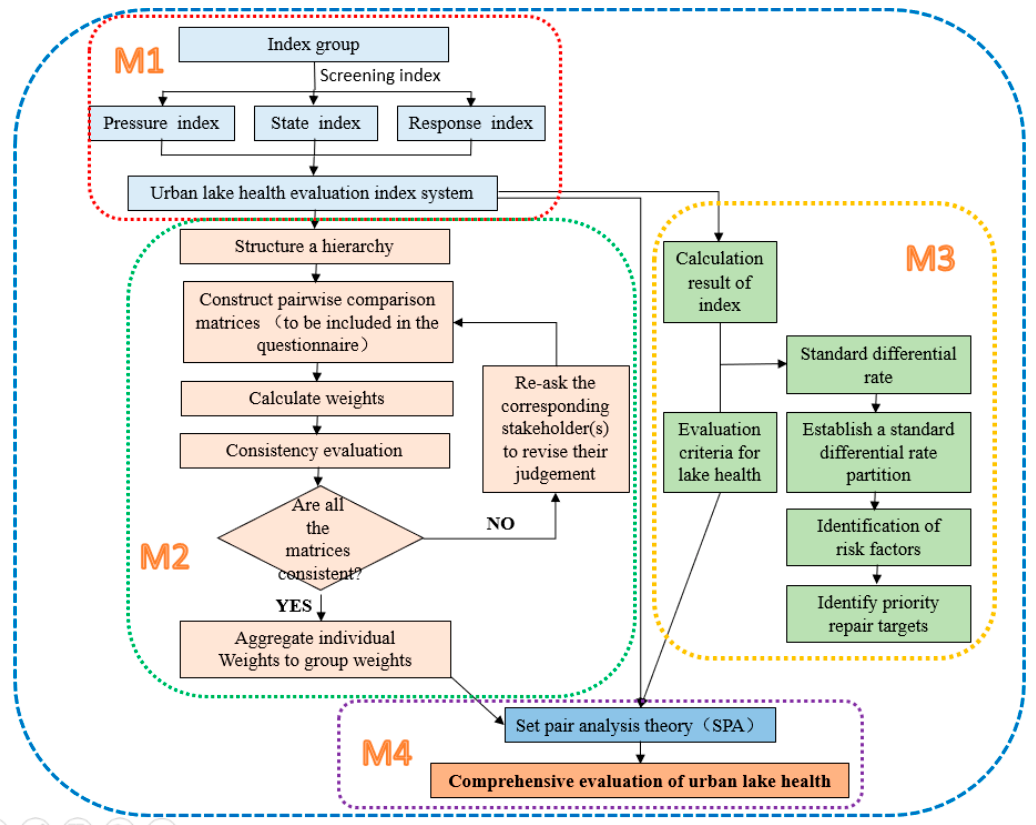
Figure 2. Framework for urban lake health evaluation.